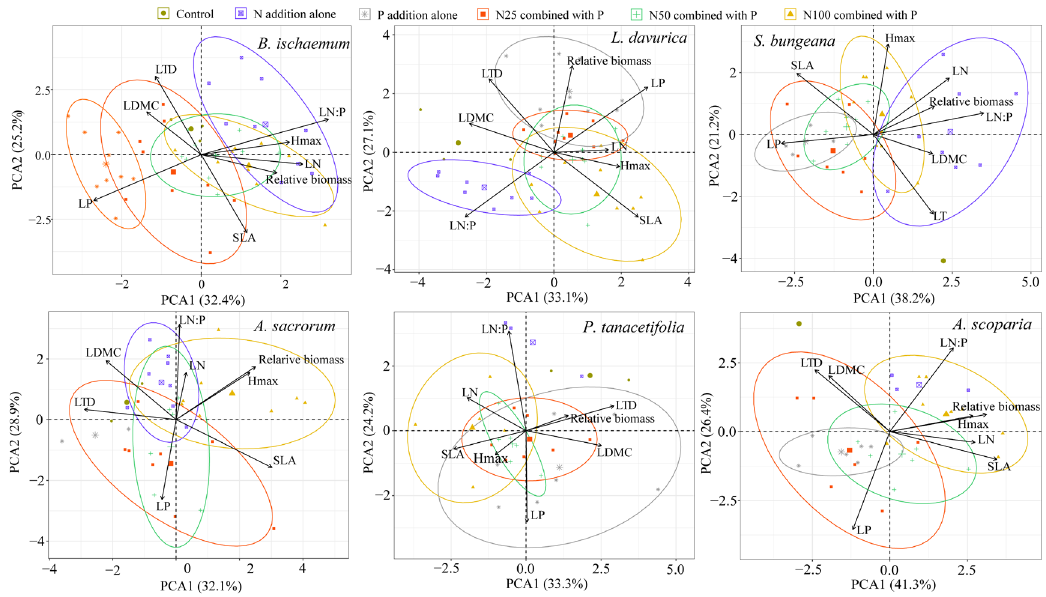
Figure 1. Principal components analysis (PCA) of the relationship between the functional traits and relative biomass of each species under different N and P levels. LN, leaf N content; LP, leaf P content; LN/P, leaf N/P ratio; SLA, specific leaf area; LTD, leaf tissue density; LDMC, leaf dry matter content; H max , maximum plant height; RB, relative biomass.